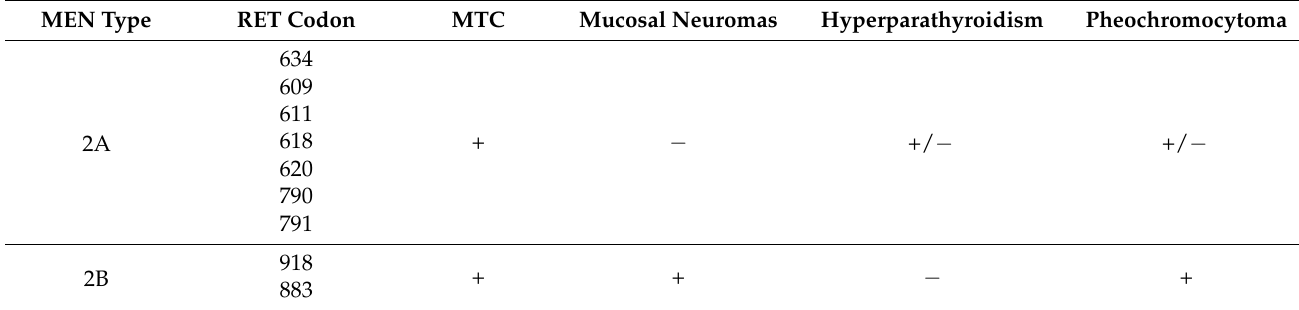
Table 4. MEN2A and MEN2B clinical features and common mutations (adapted from Update on Multiple Endocrine Neoplasia Type 2: Focus on Medullary Thyroid Carcinoma; Revised American Thyroid Association Guidelines for the Management of Medullary Thyroid Carcinoma).